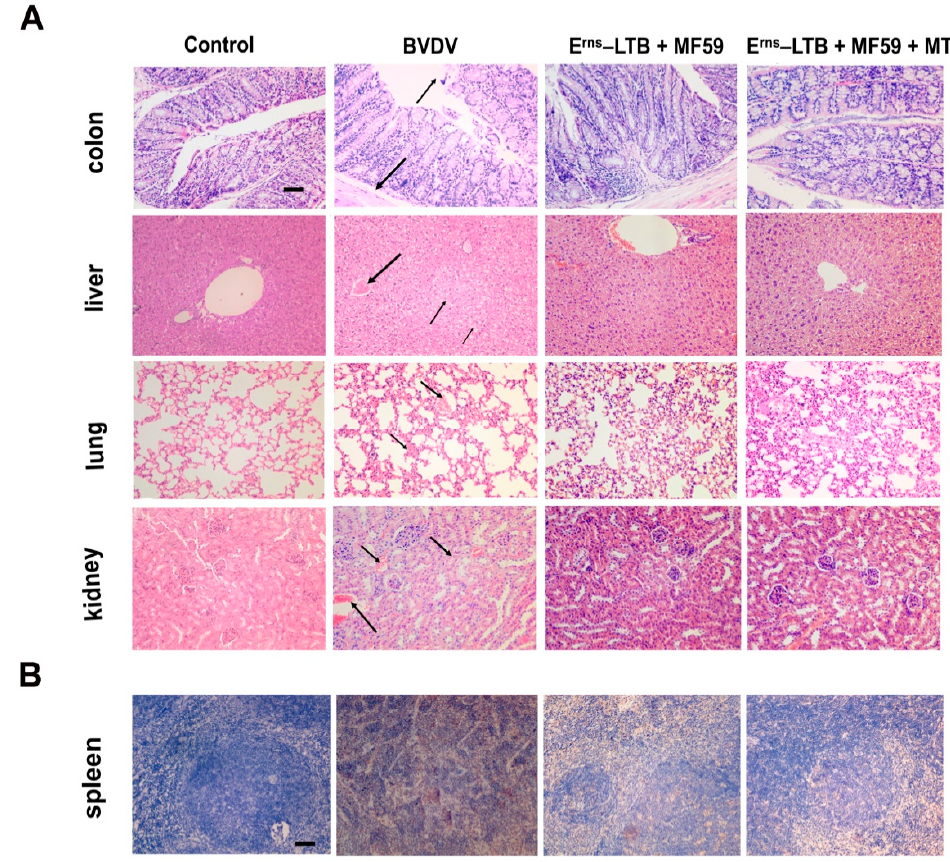
Figure 3. Detection of virus and BVDV particles following BVDV challenge. ( A ) Histopathological changes were observed in the colon, lung, liver, and kidney of the mice from each group. Scale bars, 25 µ m. ( B ) The results of BVDV E2 gene detection in the spleen tissue of different groups after the BVDV challenge. BVDV